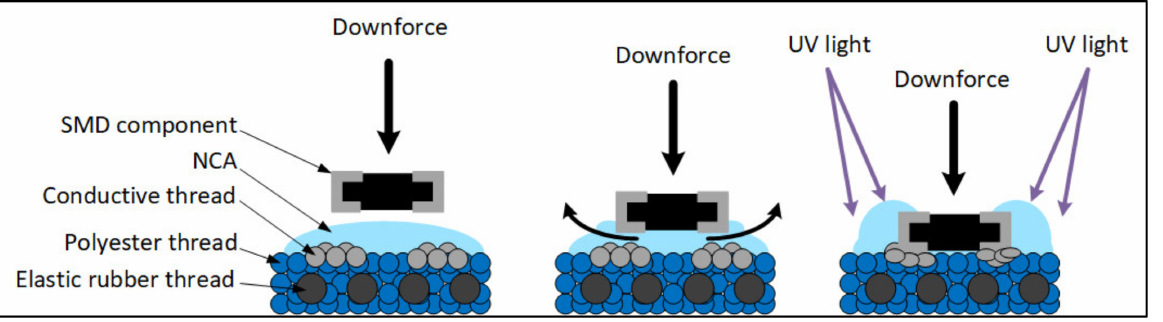
Figure 4. Principle of electrical connection of the SMD resistor to the ribbon by the NCA bonding tech-